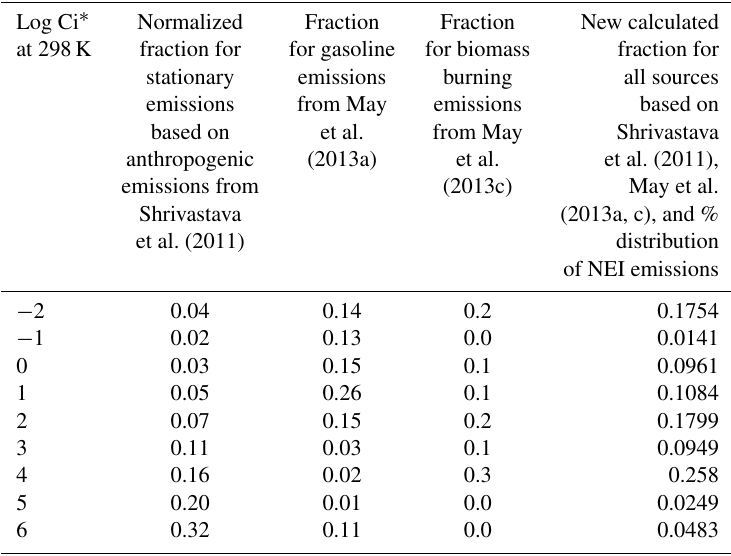
Table 3. Factors to calculate SVOC and IVOC emissions from POA emissions from Shrivastava et al. (2011) and May et al. (2013a, c) and newly calculated factors for this study. Log Ci ∗ Normalized Fraction Fraction New calculated at 298K fraction for for gasoline for biomass fraction for stationary emissions burning all sources emissions from May emissions based on based on et al. from May Shrivastava